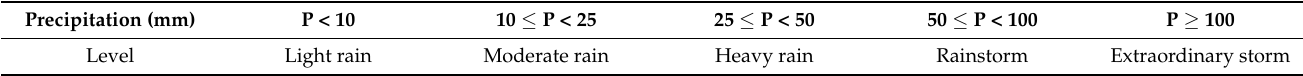
Table 1. The standard of rainfall